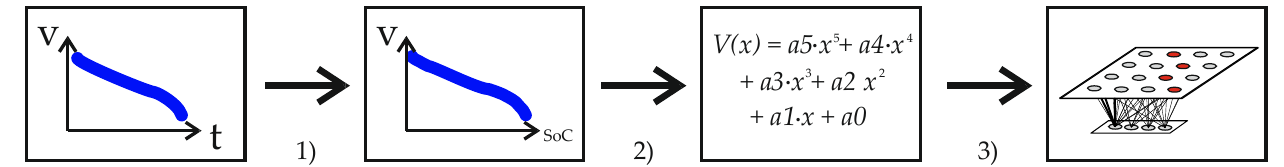
Figure 2. Methodology for cell aging analysis: ( 1 ) curve normalization, ( 2 ) feature extraction, ( 3 ) SOM training.